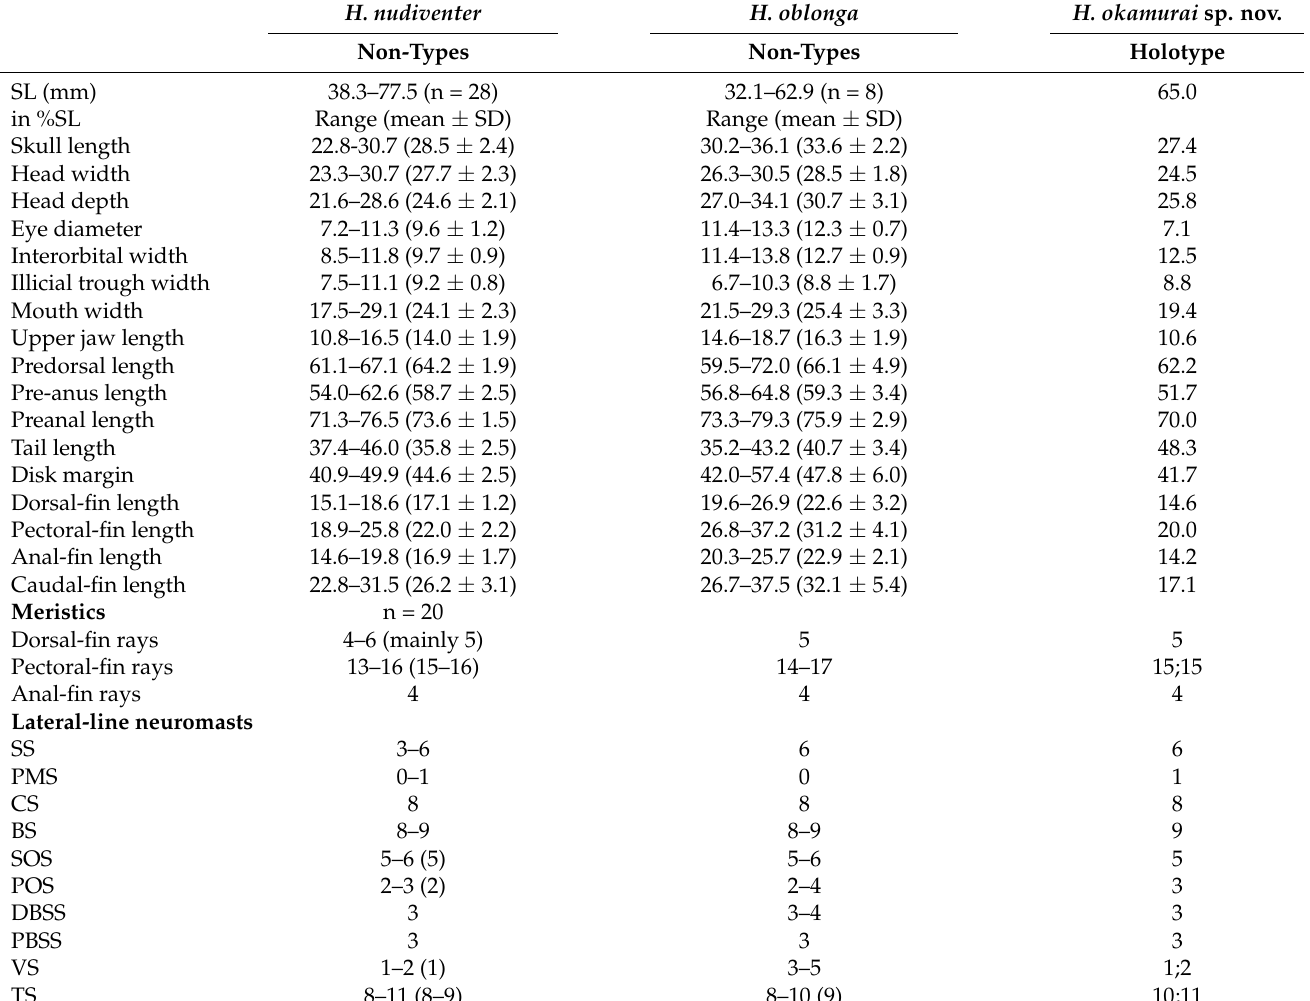
Table 8. Morphometric and meristic data of H. nudiventer , H. oblonga, and H. okamurai sp.